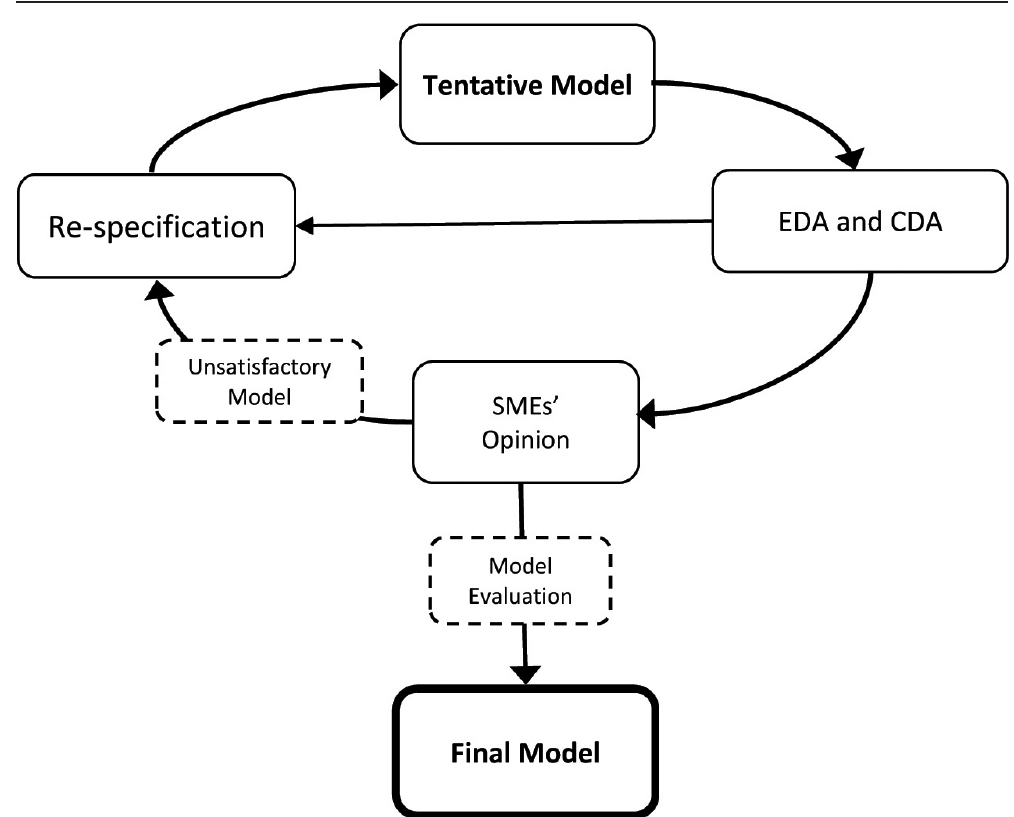
Figure 2: Iterative process of model